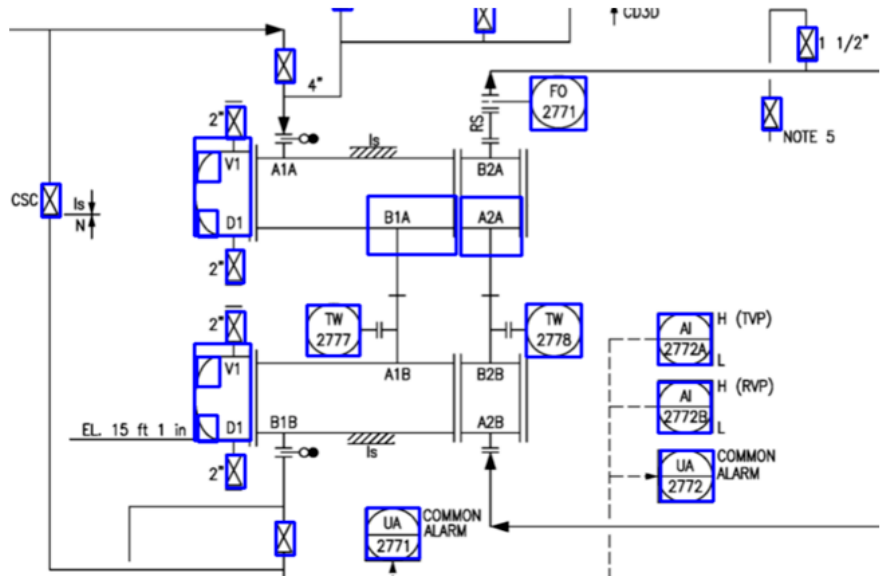
Figure 7. Sample results of the region proposal network (RPN).